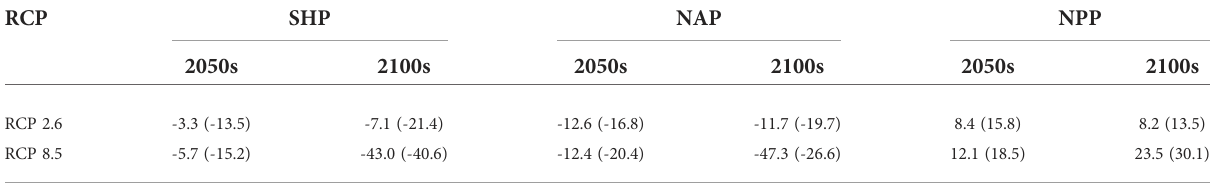
TABLE 6 Predicted size of changes (%) in species range based on population-level (species-level) models under the representative concentration pathways (RCPs) 2.6 and 8.5 at the middle (2050s) and end (2100s) of the 21 st century.